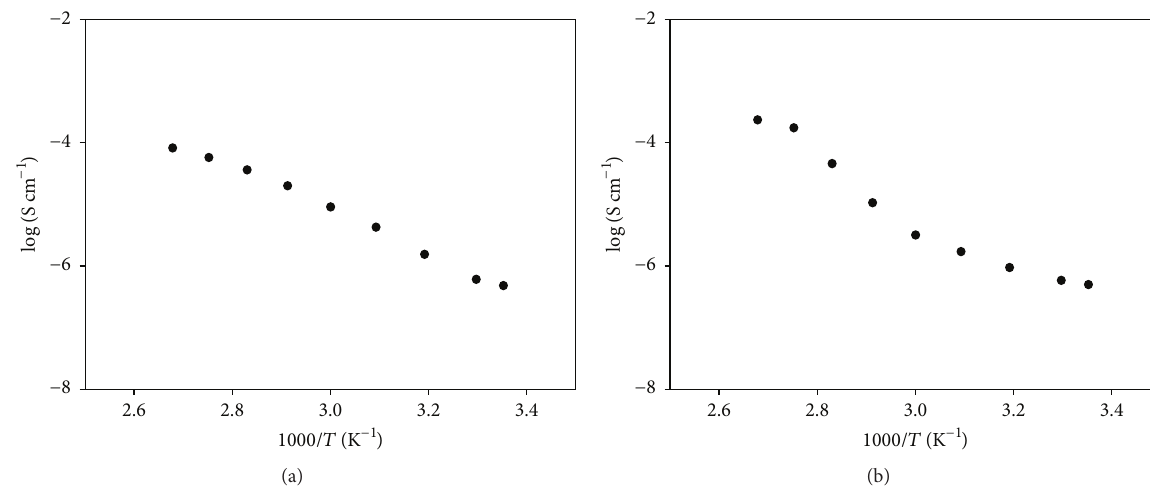
Figure 5: Temperature-dependence ionic conductivities: (a) [MG49-25.0 wt.% LiClO 4 ]:[8.0 wt.% HNO 3 -THF/TiO 2 -SiO 2 ] and (b) [MG49-